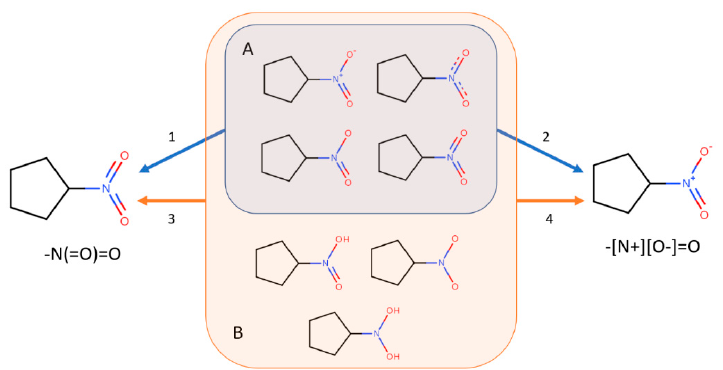
Figure 3. Standardization of the nitro group for nitrocyclopentane-like molecules. Group A (blue) shows molecules that can be standardized using the predefined standardizers (blue arrows). Arrow 1 shows the effect of the “Standardize nitro group (-N(=O)=O)” standardizer. Arrow 2 shows the effect of “Standardize nitro group (-[N+][O-]=O)”. Group B (orange) includes the molecules standardized using a custom standardizer (orange arrows). Arrow 3 shows the effect of the custom standardizer defined as “[N;D3:1](~[O;D1:2])(~[O;D1:3])>>[*+0;H0:1](=[*+0;H0:2])=[*+0;H0:3]”. Arrow 4 shows the effect of the custom standardizer defined